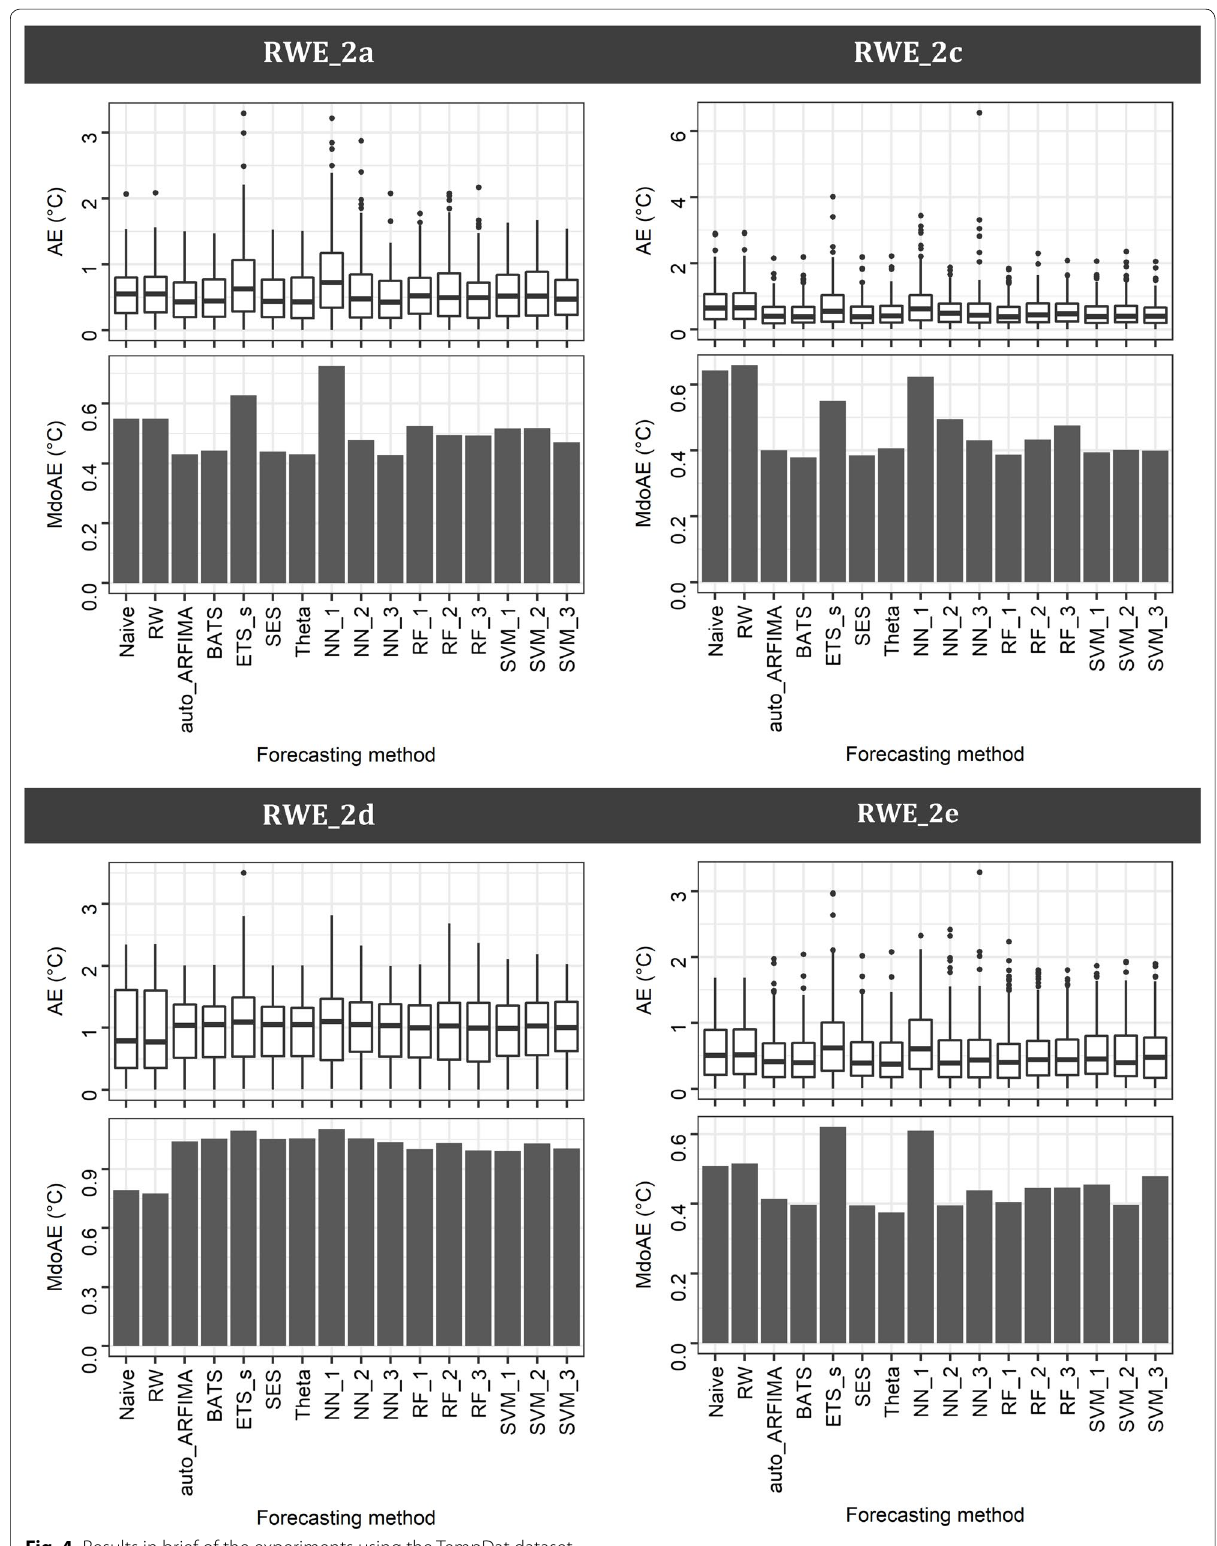
Fig. 4 Results in brief of the experiments using the TempDat